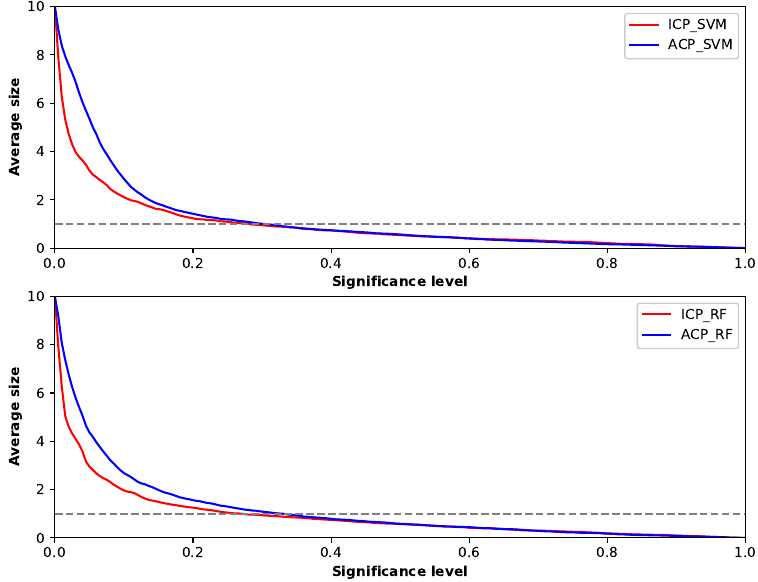
Figure 6. Average size of prediction set for different conformal predictors.